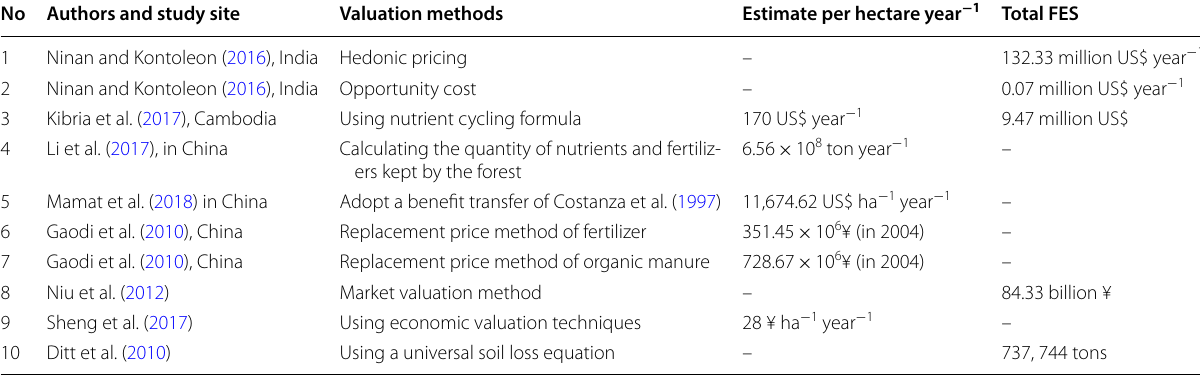
Table 7 Reviewed studies dealing with soil conservation/formation including its methodology and monetary